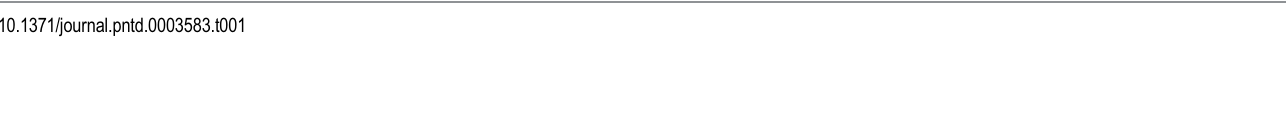
The study population enrolled into each arm were compared in terms of age distribution, baseline Mf count and antigenemia. All the four groups were similar (p > 0.05) in the baseline